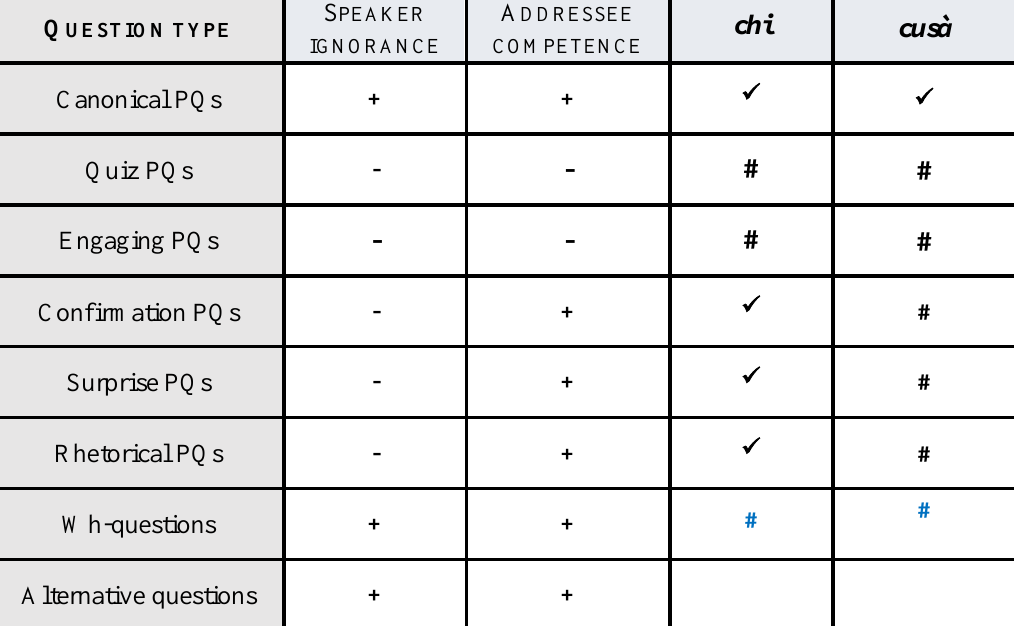
Table 1. The distribution of chi and cusà in different question